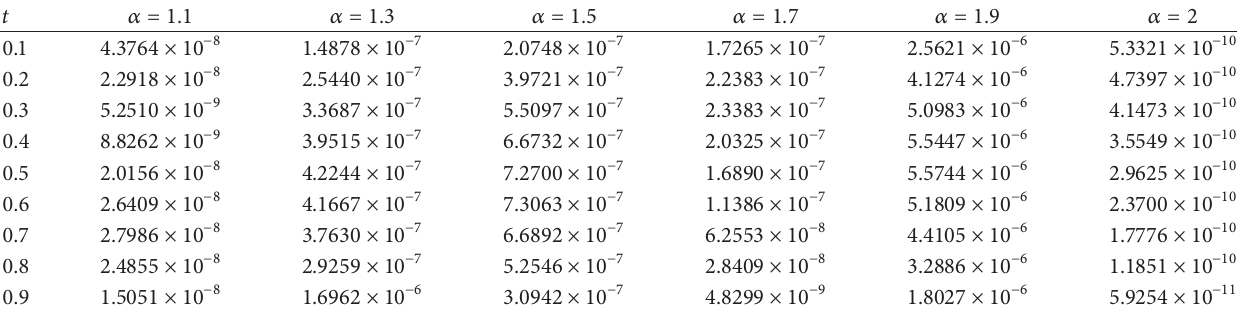
Table 4: Obtained absolute errors for 𝑀 = 20 , 𝑘 = 5 and different values of 𝛼 for Example 5.